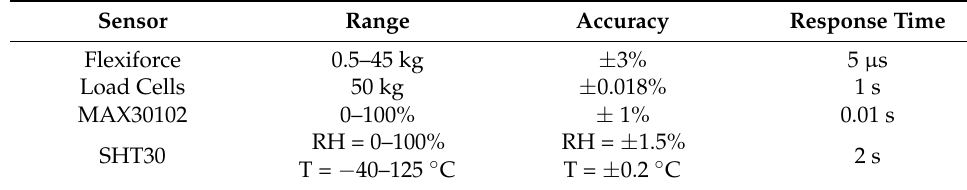
Table 1. Specifications of the sensors.